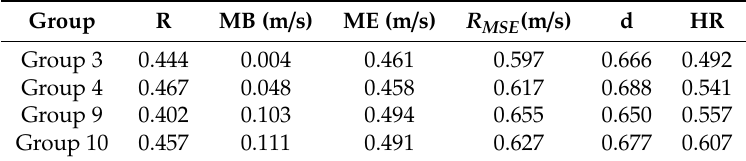
Table 8. Statistical results for the 10-m wind speed.